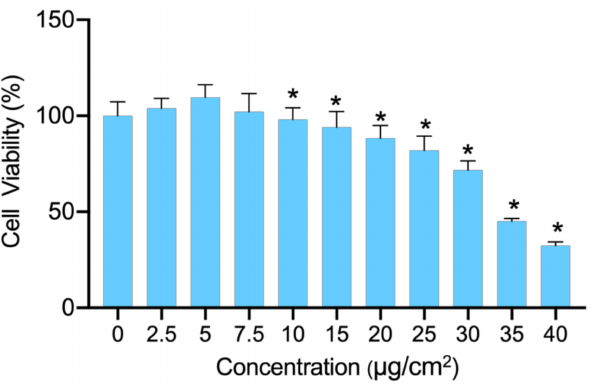
Figure 1. Cytotoxicity of PS-NPs. The viability of BEAS-2B cells after being treated for 24 h by PS-NPs at concentrations ranging from 0 to 40 µ g/cm 2 ( n = 6). * p -value < 0.05 indicates statistically significant differences from the